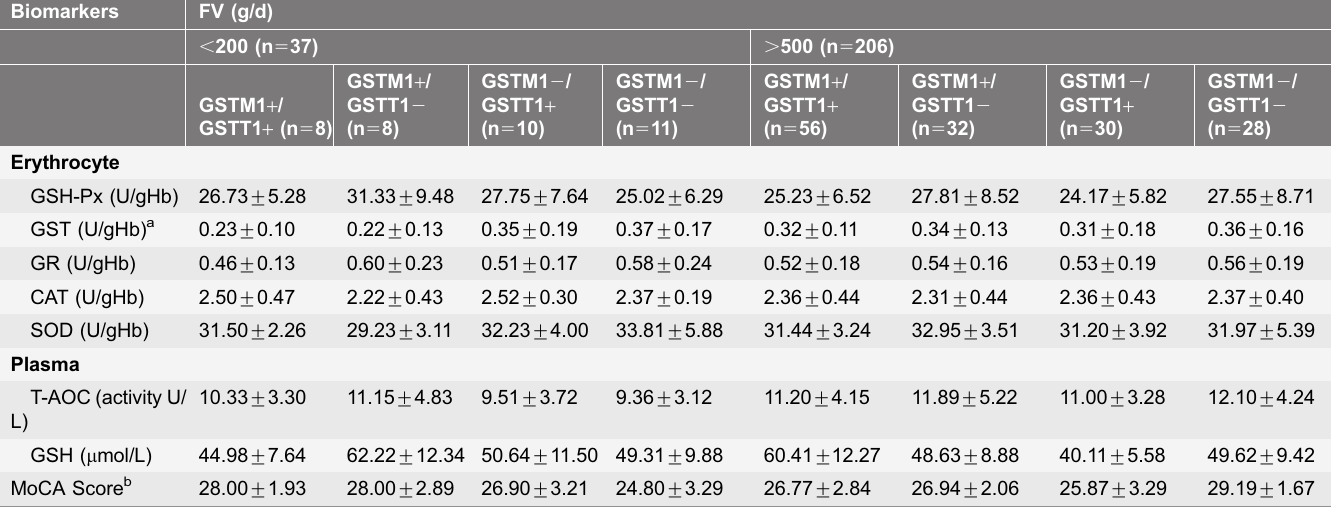
Table 6. Antioxidant parameters and cognitive function according to FV consumption and combined GST genotype.